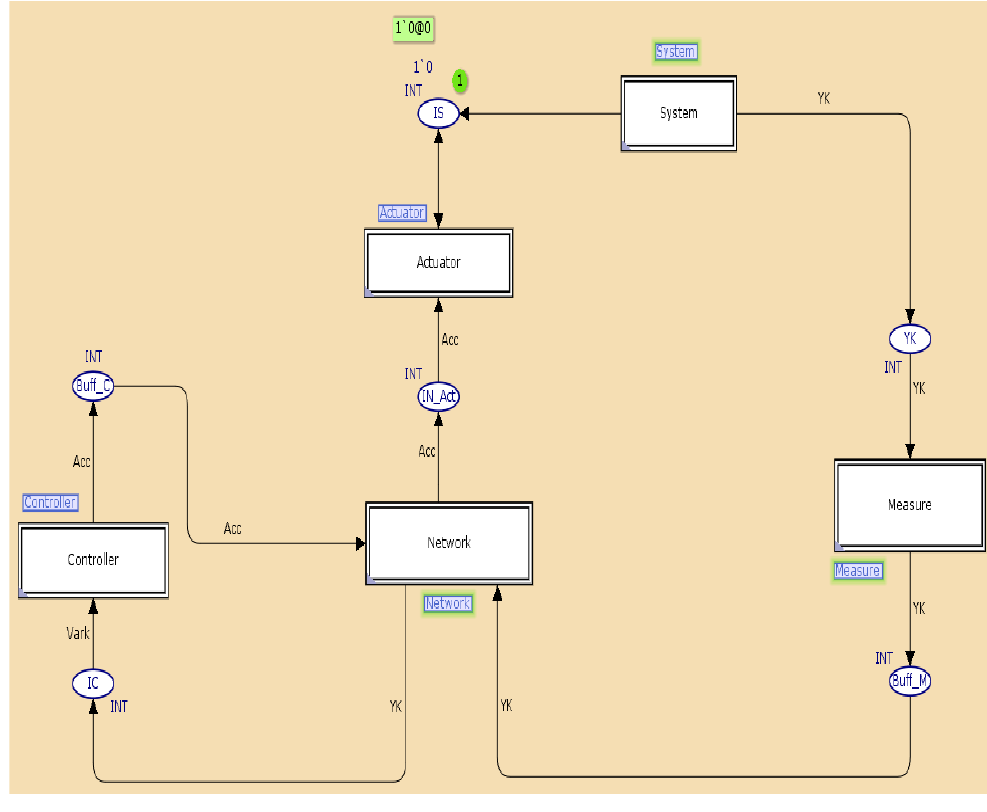
Figure 7. Hierarchical representation of the